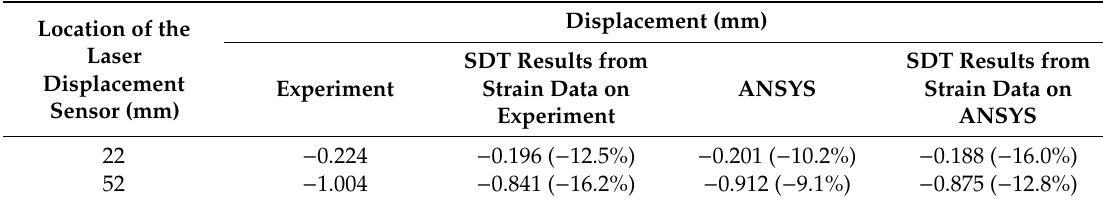
Figure 12. Displacement estimation results using the SDT matrix (multi-material). Table 6. Displacement estimation results using the SDT matrix (multi-material).